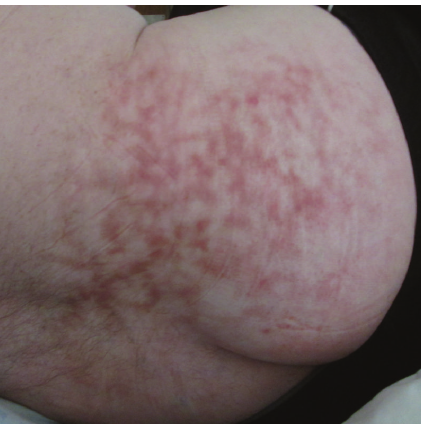
Figure 1: Cutaneous lesions of erythema ab igne in a hospitalized patient with a history of long-term heating pad use.